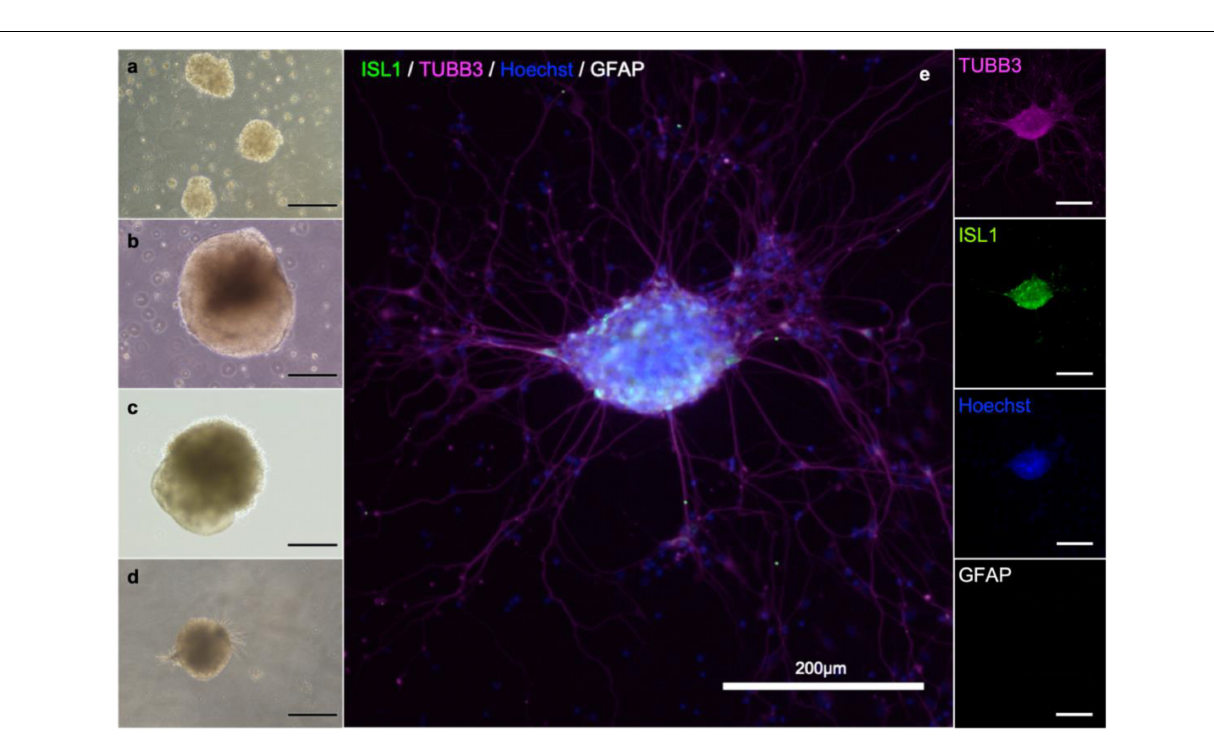
Frontiers in Integrative Neuroscience |